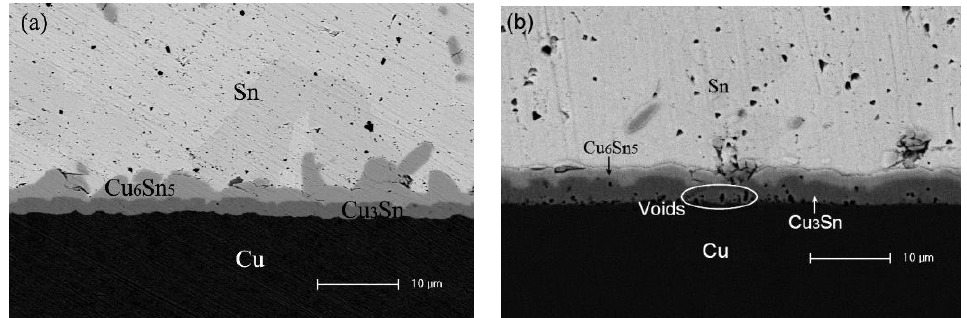
Figure 4. Interfacial microstructure of Sn/EP Cu joints with different aging conditions, ( a ) 150 °C for 120 h, ( b ) 180 °C for 72 h.